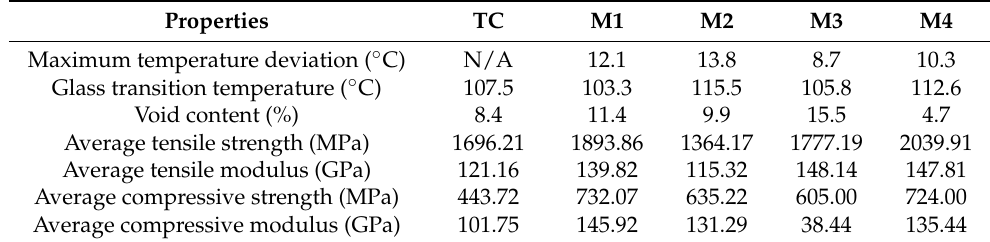
Table 3. Physical and mechanical properties of composite